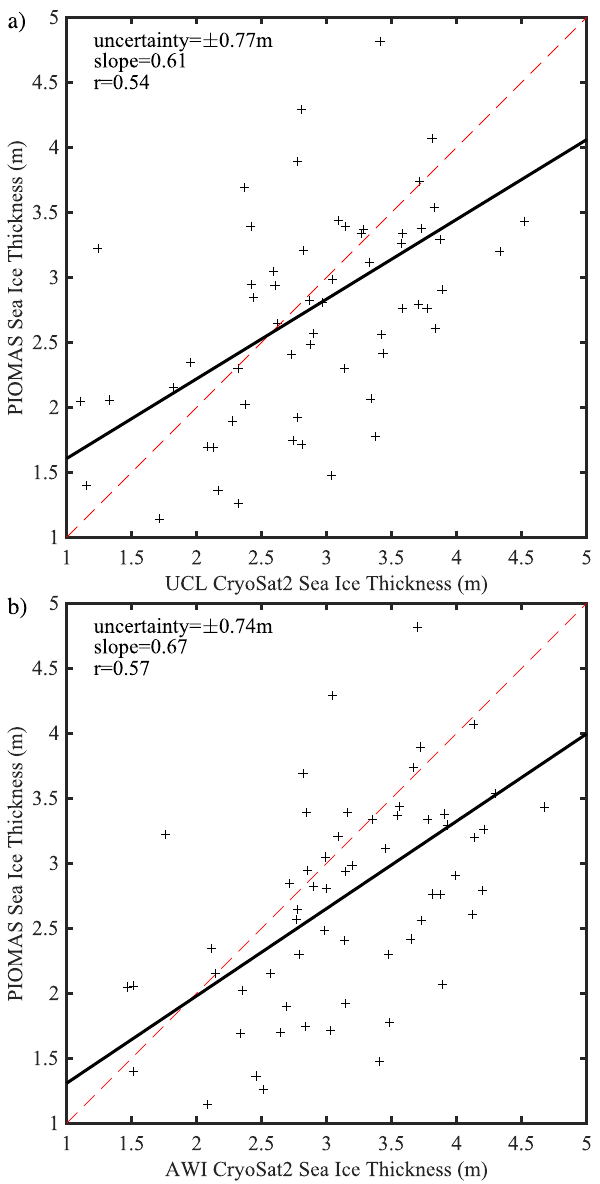
Fig. 7 Observed and modeled sea ice thickness for the Lincoln Sea region 2010 – 2019. Scatterplots of the observed monthly mean: a University College London (UCL) and b Alfred Wegener Institute (AWI) CryoSat2 satellite data versus sea ice thickness from the PIOMAS model.